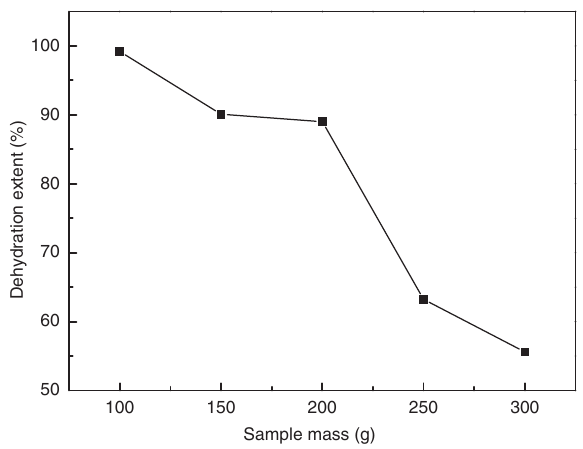
Figure 12: Effects of sample mass on dehydration extent of high titanium slag under microwave drying (microwave power: 700 W; bed depth: 10 mm; drying time: 50 s).